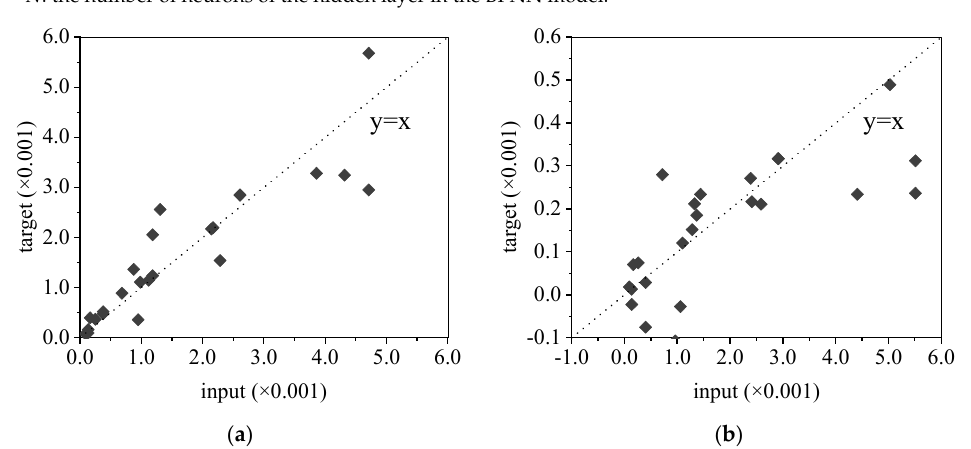
Figure 23. The relationship between predicted values and original values of the whole dataset: ( a ) for α , ( b ) for λ . α , ( b ) for λ